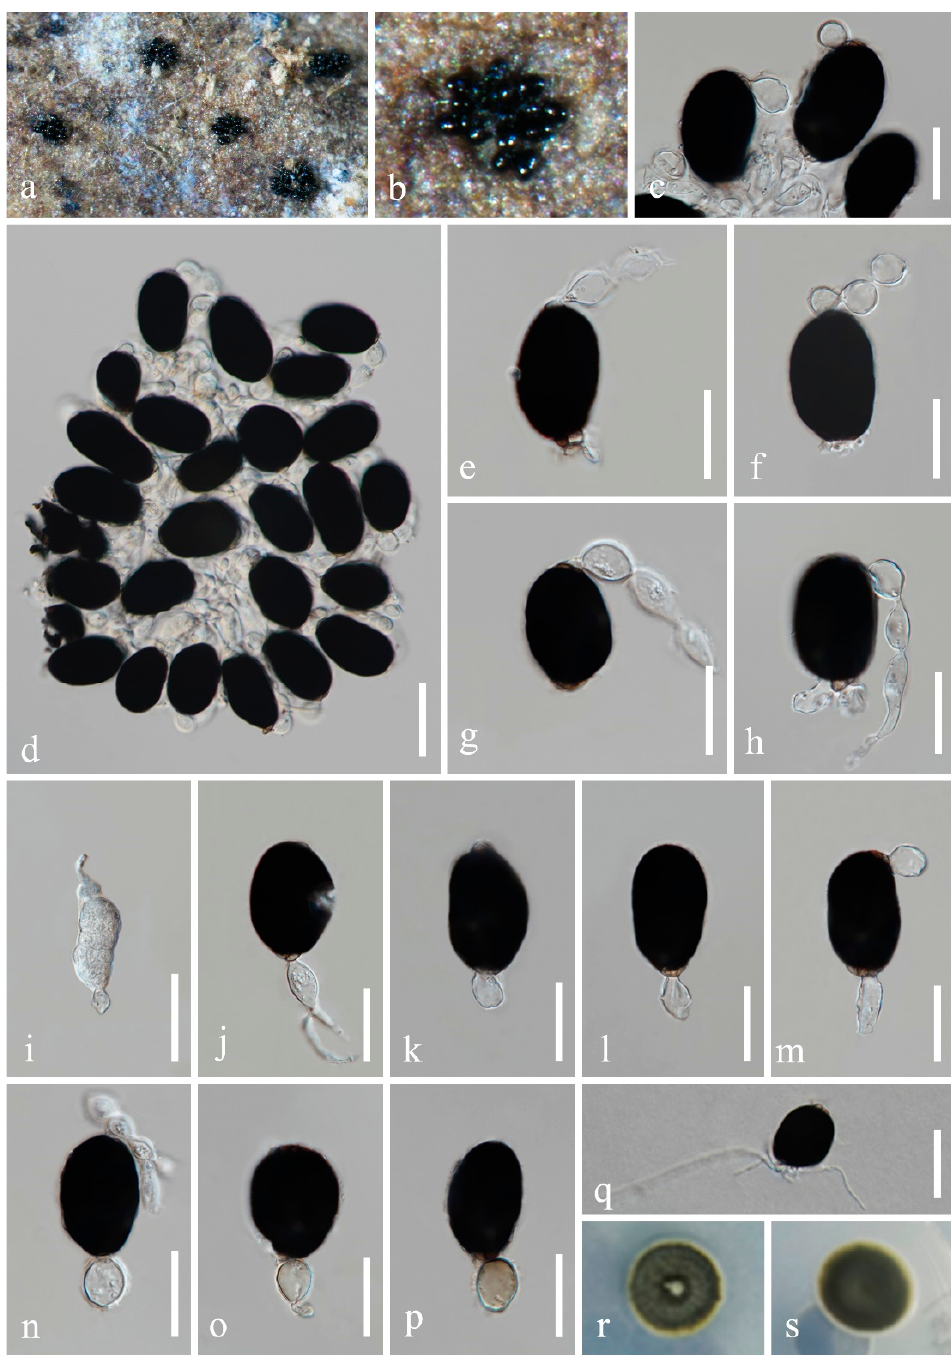
Figure 2. Fuscosporella guizhouensis (HKAS 122794, holotype). ( a , b ) Colony on submerged wood. ( c , d ) Conidiophores with conidia. ( e – h ) Conidia with apical appendages. ( i − p ) Conidiogenous cells and conidia. ( q ) Germinated conidium. ( r , s ) Colony on PDA (r from above, s from below). Scale bars: ( c ) = 30 μ m, ( d ) = 40 μ m, ( e − p ) = 30 μ m, ( q ) = 40 μ m.